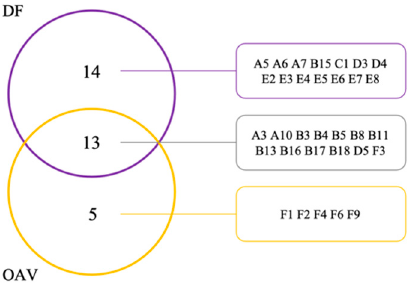
Figure 4. Distribution of aroma-active compounds identified in blended juices and rehydrated juices by DF and OAV (numbering refers to Table 2).